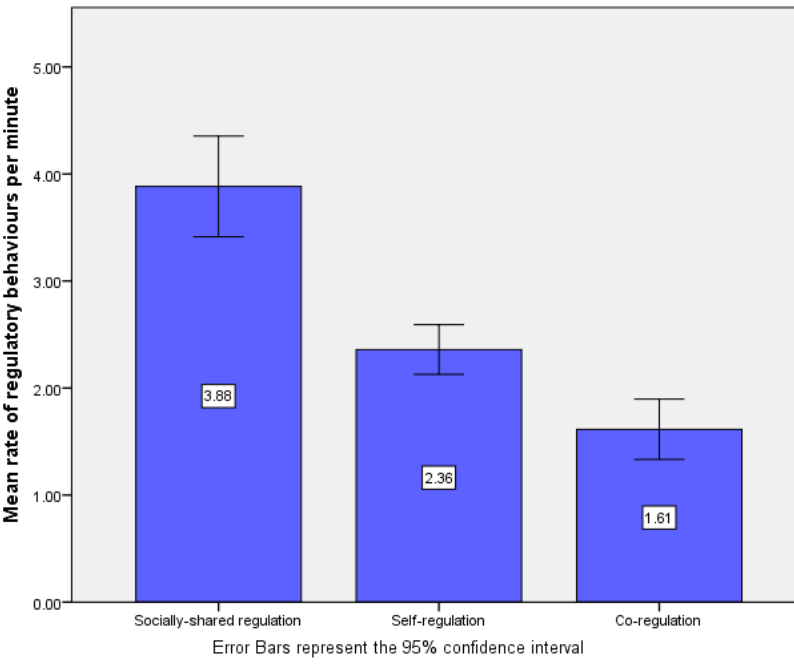
Figure 3. Bar graph of mean rates per different social intentionality during musical